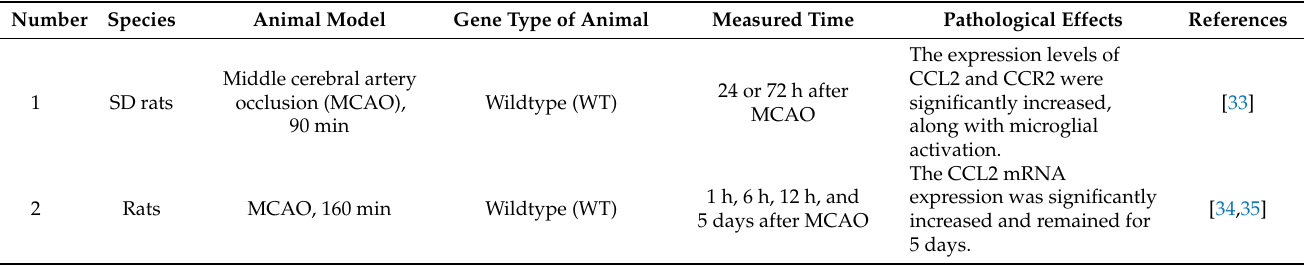
Table 1. The C-C motif chemokine ligand 2/CC chemokine receptor 2 (CCL2/CCR2) signaling pathway and cerebral